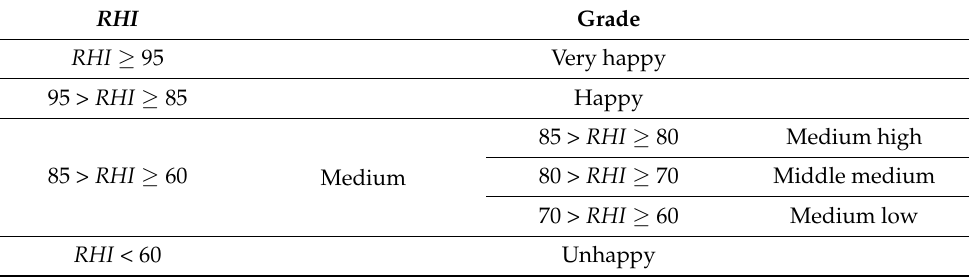
Table 4. Grading standard for the RHI .